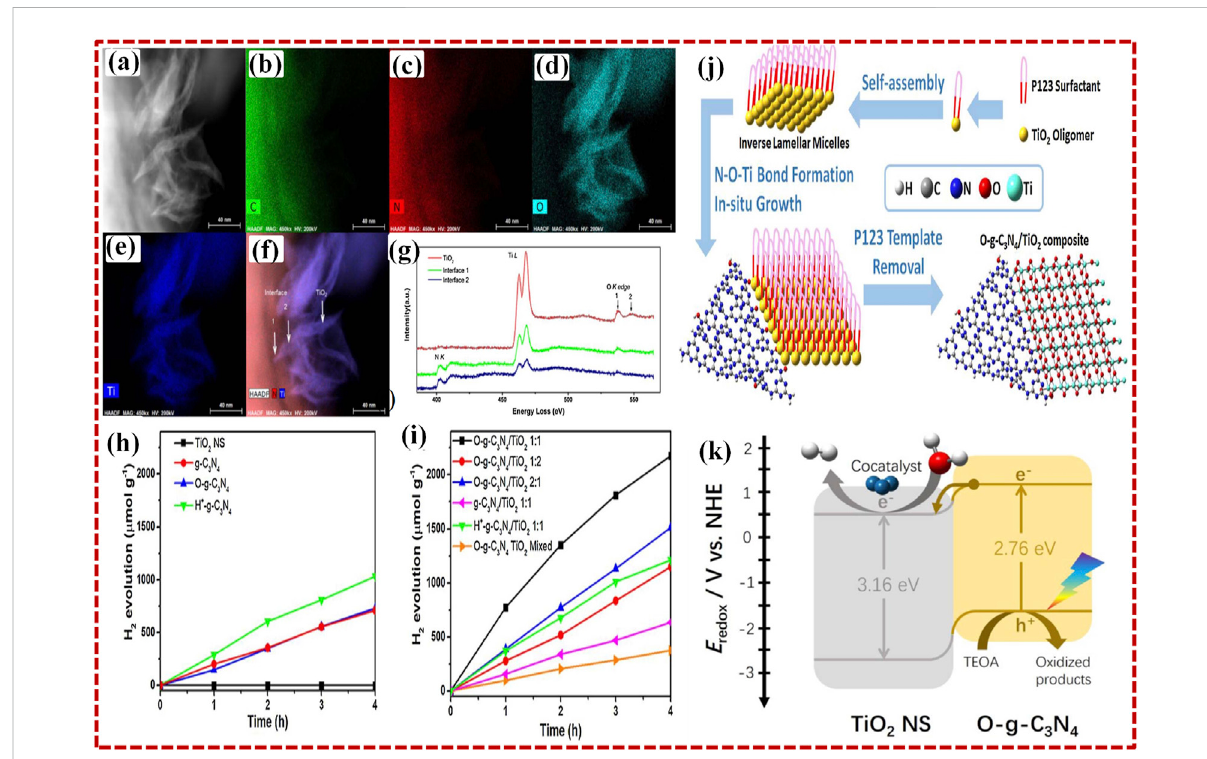
FIGURE 6 (A) RelevantHAADF-STEMpictureandEDSelementalmapoftherespectiveregionsof2DO-g-C 3 N 4 /TiO 2 photocatalystC (B) ,N (C) ,O (D) ,and Ti (E) . (F) superposed N, Ti, and HAADF maps revealing the interface areas and TiO 2 leaves. (G) NK edge, Ti L edge, and O K edge as seen in EELS spectra of interface and TiO 2 region. (H) H 2 production plot vs. time of TiO 2 NS, g-C 3 N 4 , O-g-C 3 N 4 , H + - g-C 3 N 4 , and (I) composites of O-g-C 3 N 4 / TiO 2 atratiosof1:1,1:2,2:1,2Dg-C 3 N 4 /TiO 2 (1:1),H + -g-C 3 N 4 /TiO 2 (1:1),andmixedO-g-C 3 N 4 TiO 2 (J) schemeofthefabricationofO-g-C 3 N 4 / TiO 2 composite. (K) Suggested mechanism for photocatalytic H 2 production on O-g-C 3 N 4 /TiO 2 (1:1) composite using irradiation by